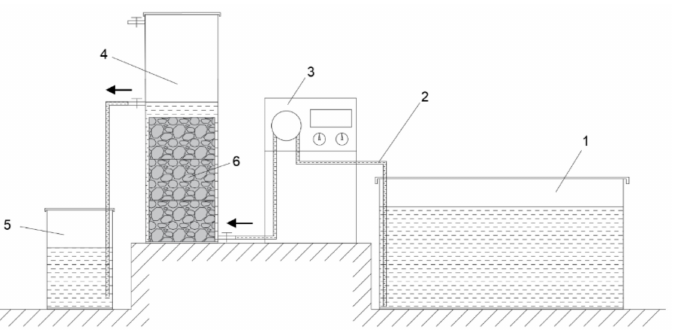
Figure 2. Laboratory scale road runoff heavy metal removal experimental facility. 1—liquid storage vessel, 2—rubber tube, 3—peristaltic pump, 4—reaction vessel, 5—collection vessel, 6—asphalt concrete